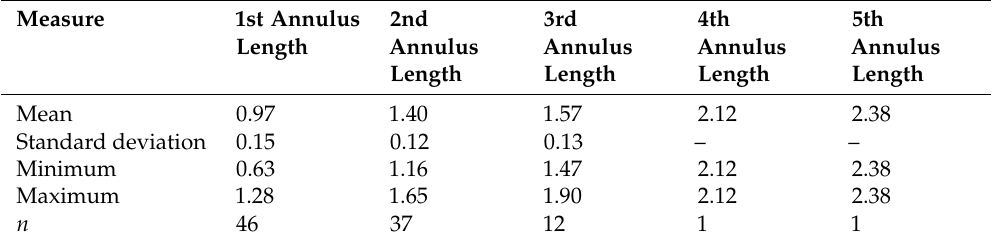
Table 1. Measurements of distances from core to annuli. All measurements are presented in mm. Standard deviation could not be calculated for the fourth and fifth annulus measurements because the sample size was 1.